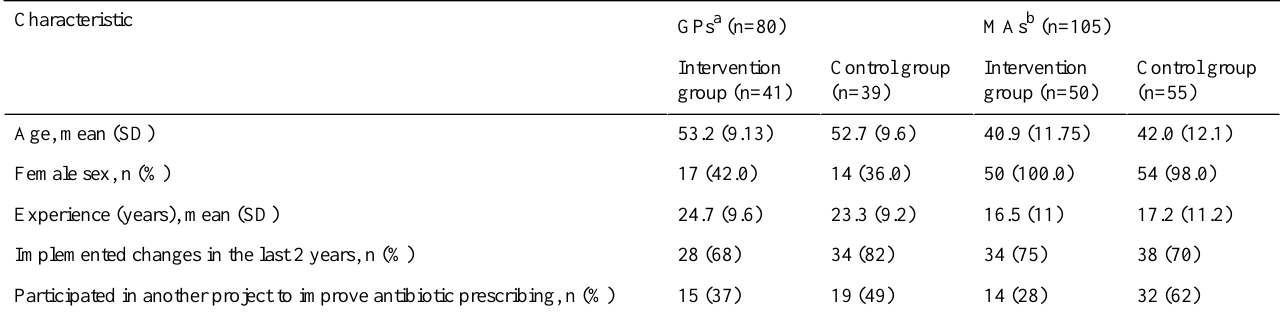
Table 1. Sociodemographic characteristics of the survey participants (T1) in this study